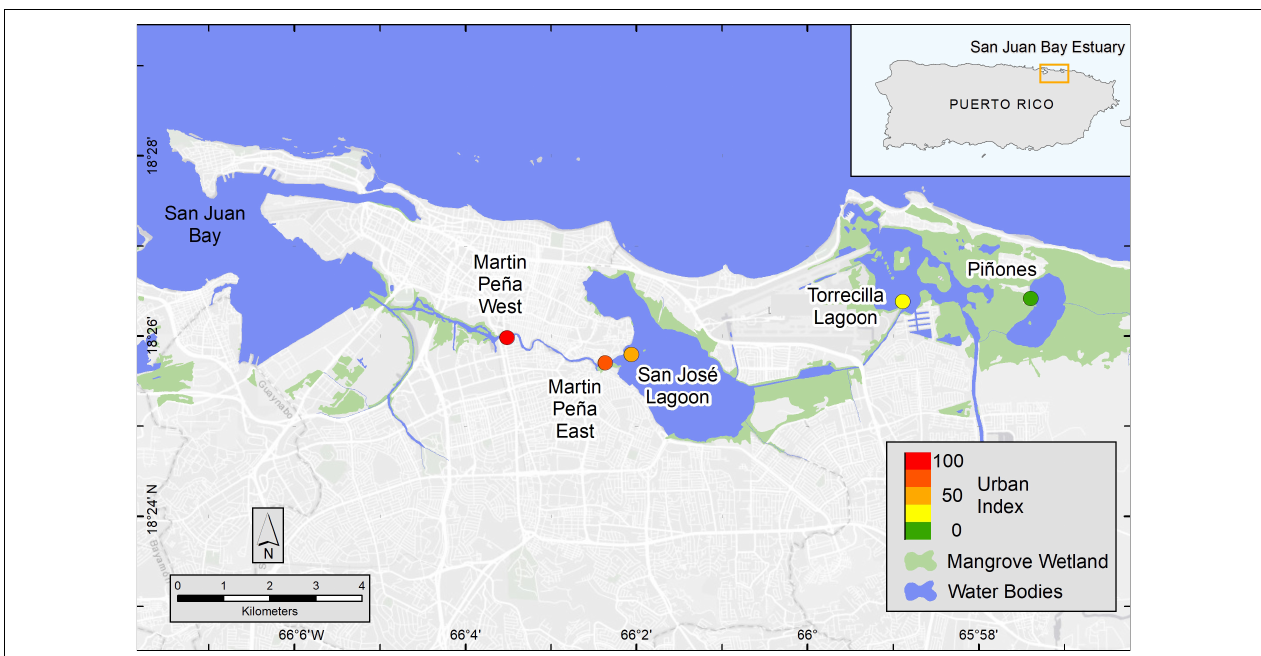
FIGURE 1 | Map of San Juan Bay Estuary mangrove study sites and urbanization score (colored circles). The Urban Index was scored on a scale from 1 to 100 and based on surrounding coverage of mangrove wetland, non-mangrove vegetation and open water, urban land, population density, and road density, which were determined in a 500 m buffer from the approximate center of the mangrove site. National Wetland Inventory data were used to map mangrove wetlands, which included estuarine, intertidal, forest and scrub shrub, broad-leaved evergreen habitats (U.S. Fish and Wildlife Service,